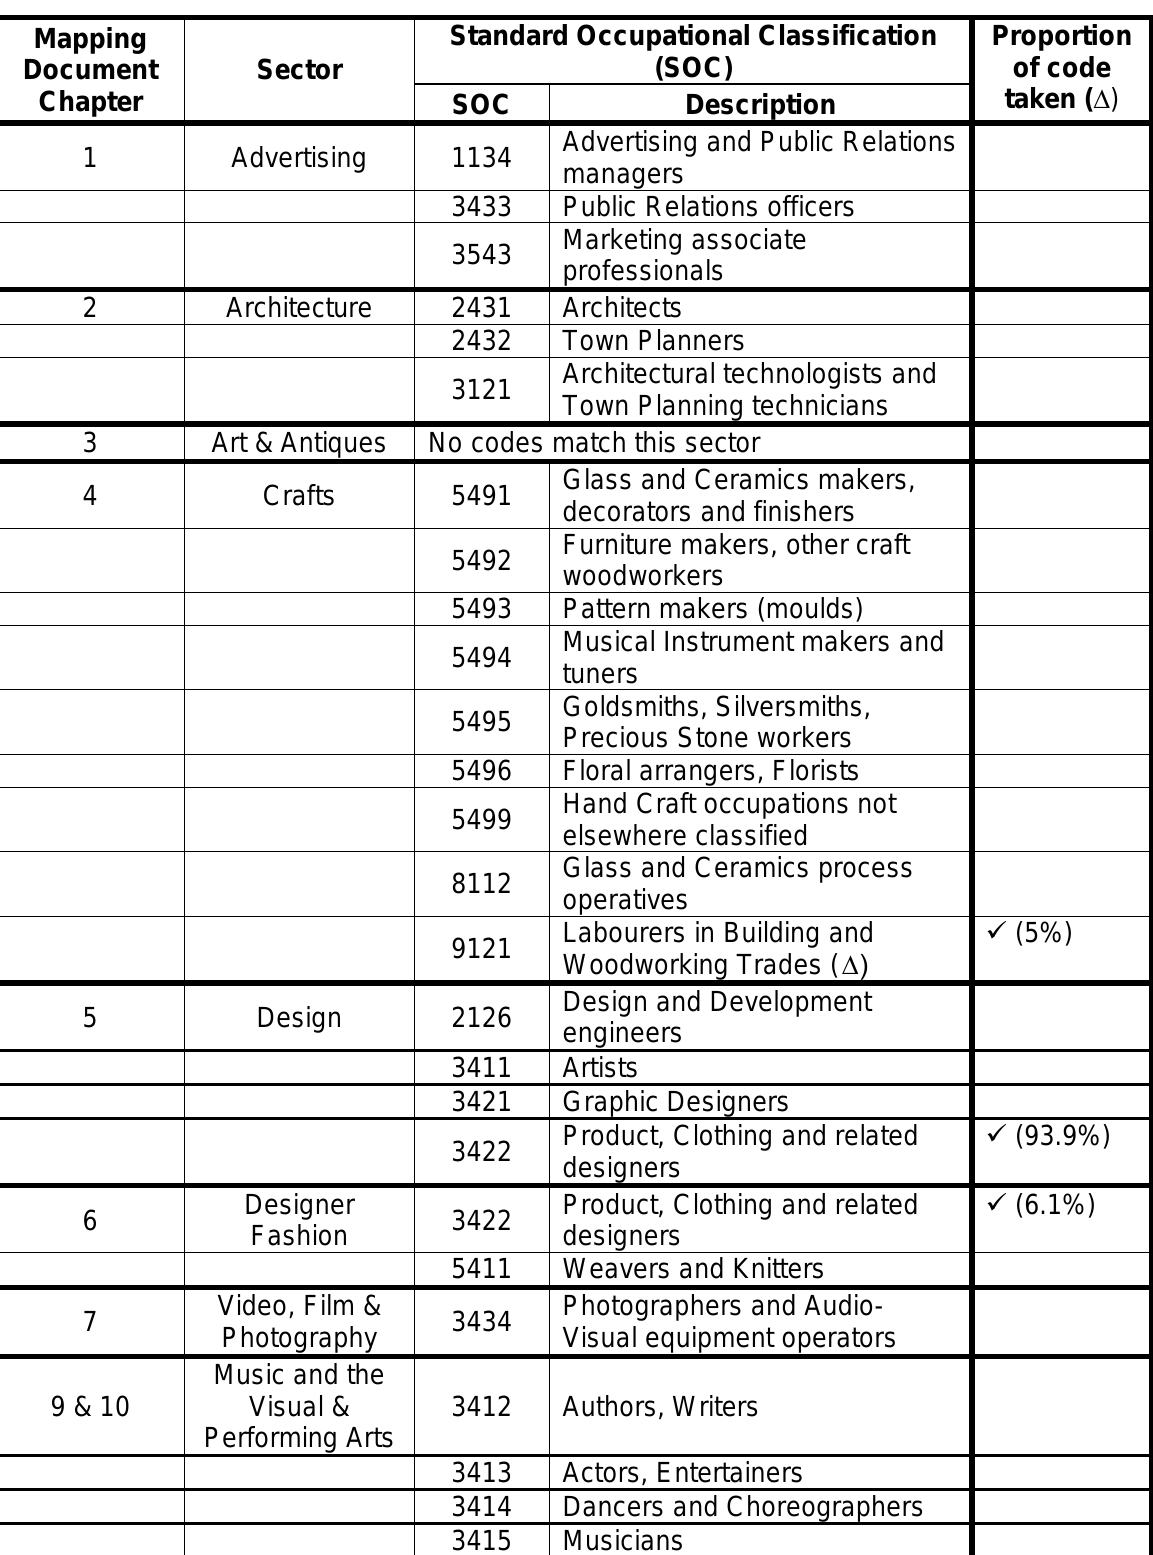
Table A3 – Mapping of the Creative Industries to the 2000 Standard Occupational Classifications (SOC), to estimate number of creative jobs outside of businesses in the Creative